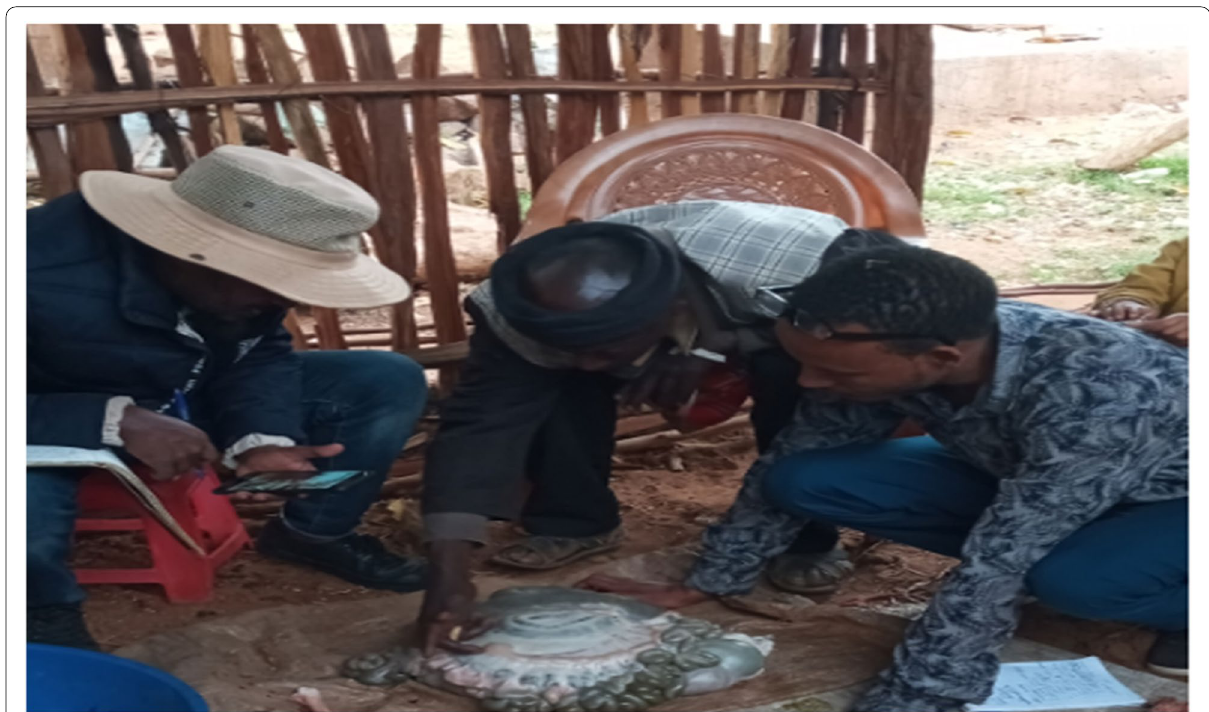
Fig. 2 Intestine reading session, 20 August 2021